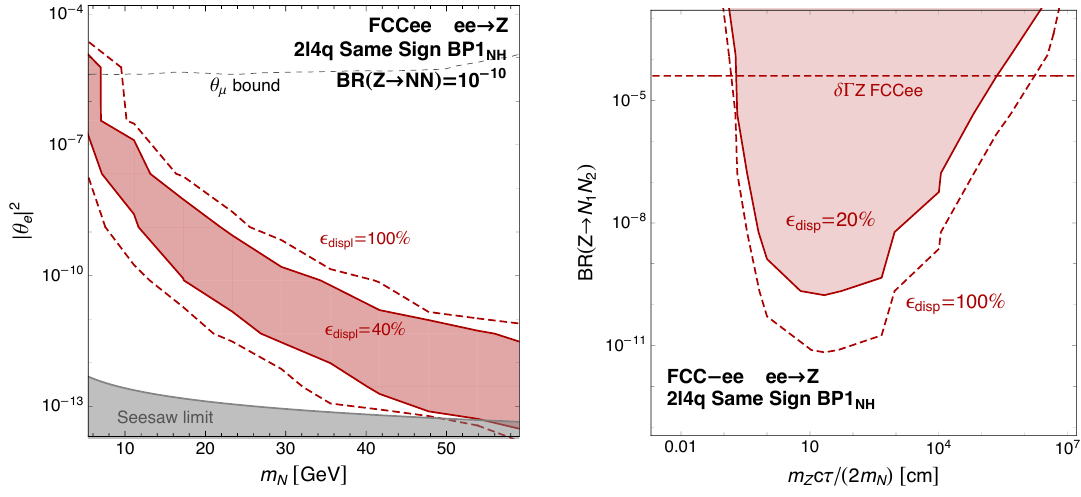
Figure 13 . Left: 95% CL exclusion for BP1 NH in the m N − | θ e | 2 plane from displaced decay searches assuming BR( Z → N 1 N 2 ) = 10 − 10 for the case of FCC-ee. The gray dashed line represents the limit on the mixing angle arising from existing experimental searches. In the gray shaded region the lightness of the neutrino masses cannot be explained by the see-saw mechanism. Right : 95% CL exclusion for BP1 NH in the m Z cτ − BR( h → N 1 N 2 ) plane from displaced decay searches. 2 m N The horizontal red dashed line represents the limit arising from the FCC-ee Z boson total width measurement with an uncertainty of 100